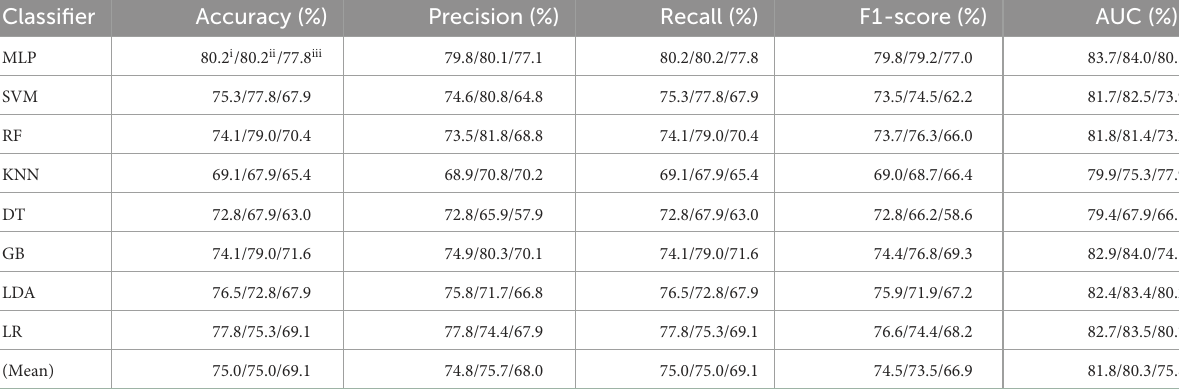
TABLE 3 Evaluation metrics of the different classifiers with three selected features (Experiment 2) on the test